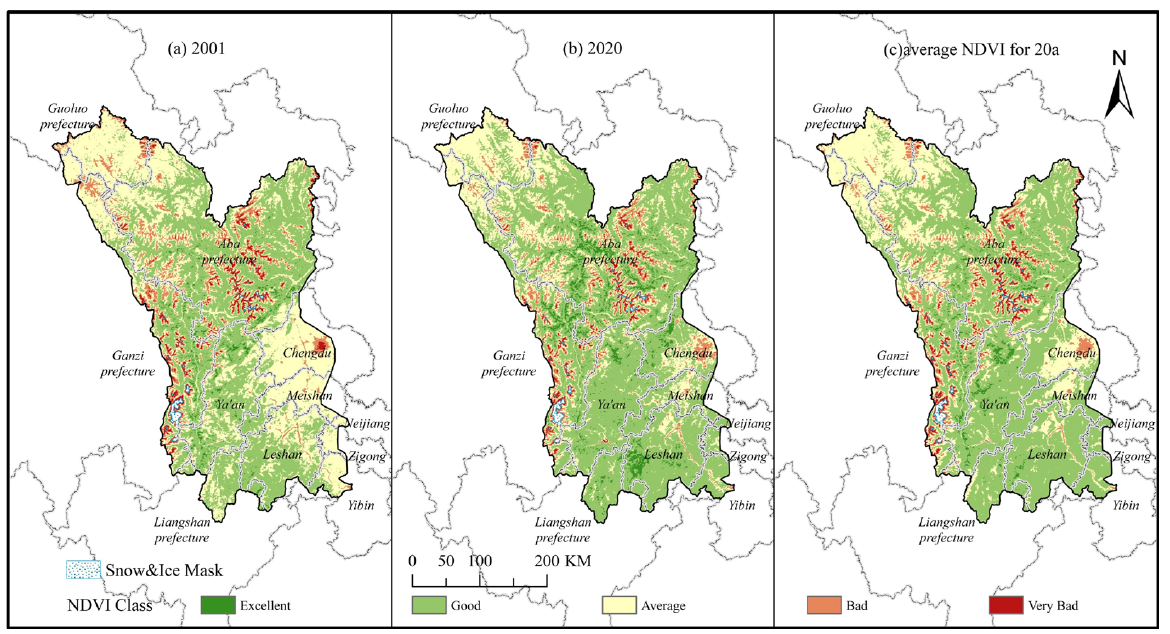
Figure 3. Spatial distribution of NDVI in Minjiang River Basin during the growing season.